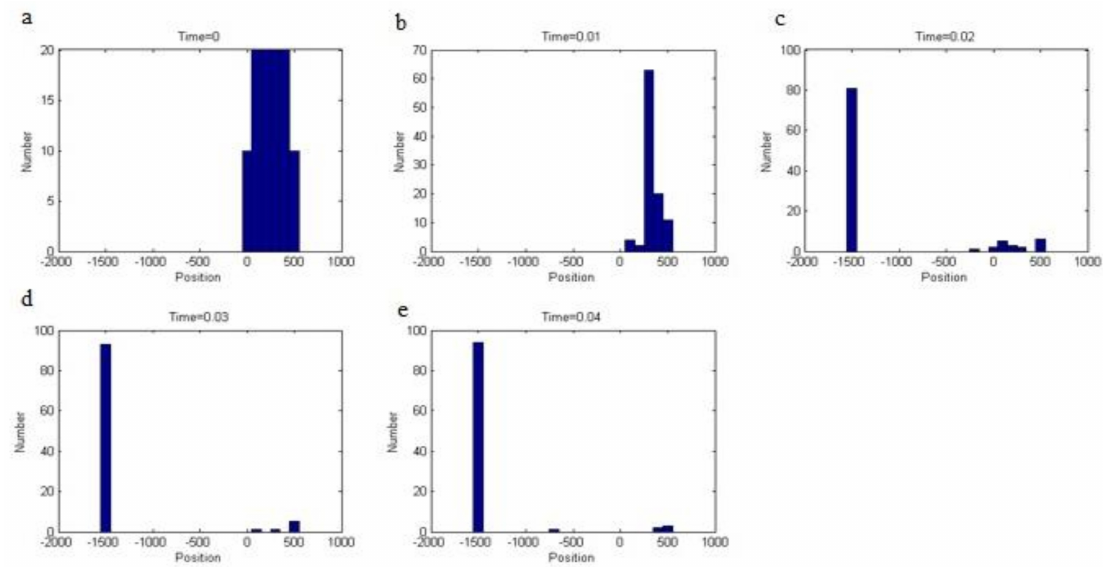
Figure 16. The histogram of particle vertical position at different times: the position is given in microns. As the time progressed (moving from graph ( a – e )), the band width of particle distribution is reduced and the particles are all gathered in the same location.